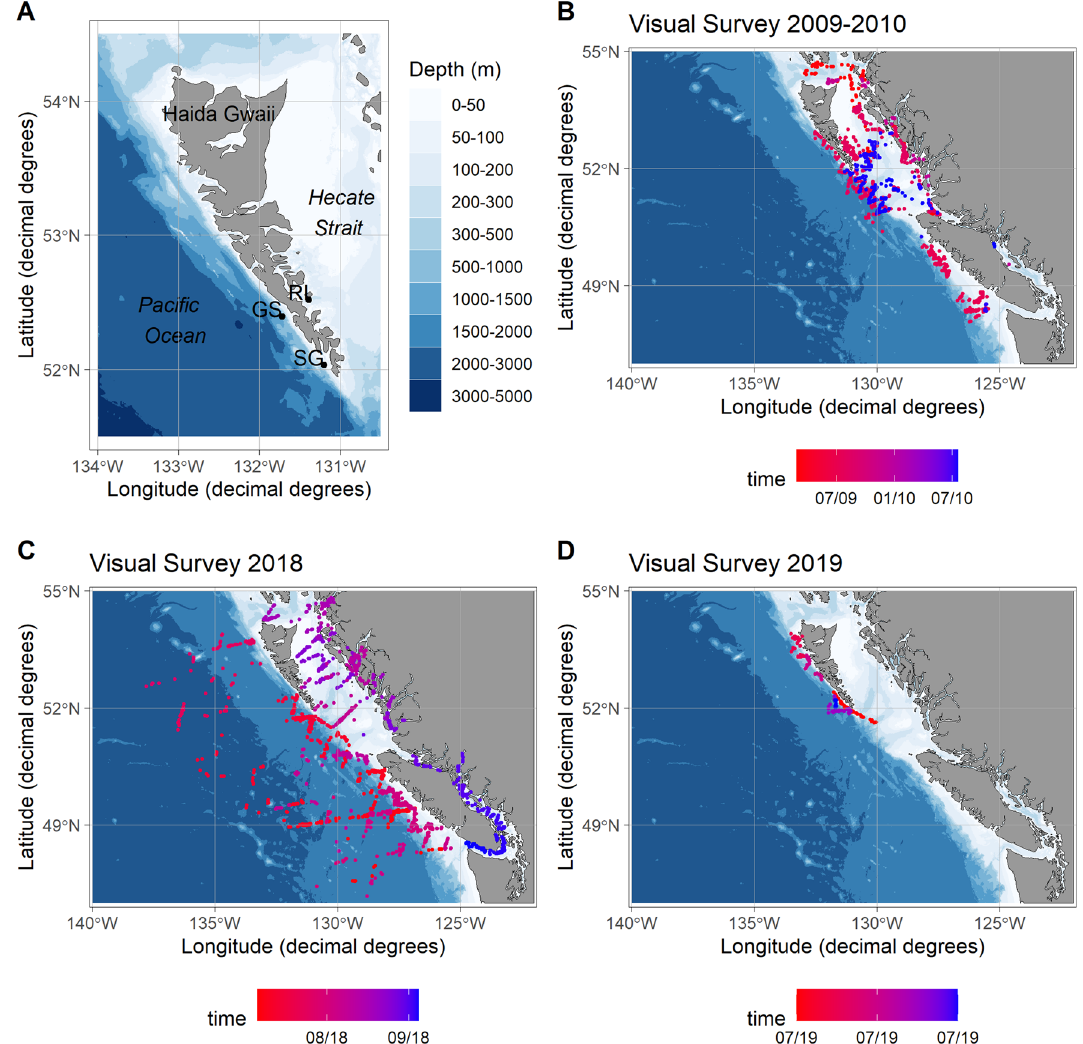
Figure 1. ( A ) Map of Haida Gwaii, BC, Canada, showing the three hydrophone locations (black dots)— Gowgaia Slope (GS, 2017–2019), SG ̱ ang Gwaay (SG, 2009–2011) and Ramsay Island (RI, 2018–2019). ( B – D ) Maps showing location and timing (month/year) of cetaceans sightings that overlapped with acoustic recording periods ( B : 2009–2010; C : 2018; and D : 2019). Maps were created using the ggOceanMaps package (version 1.2.6) in R 122